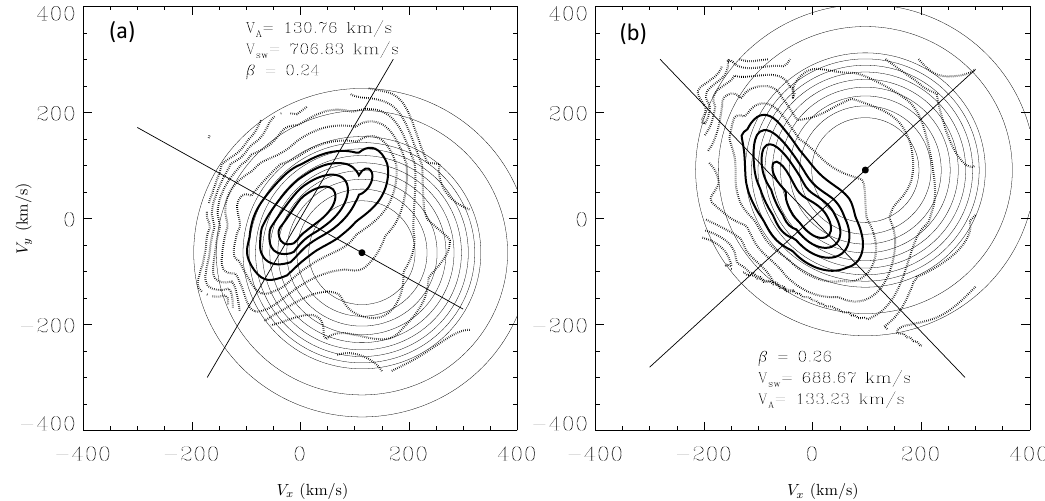
Fig. 3. Proton velocity distribution functions in fast solar wind, presented in the same format as in the previous two figures. Close inspection shows, however, the more strongly deformed cores (continuous contours), which are bent around and nestled to the circular diffusion lines and reach out to the positive half of velocity space. The measurements of the VDFs were made on 14 April 1976 at the times (hours:minutes:seconds): (a) 21:59:53 and (b) 22:24:14. The data correspond to a heliocentric distance of